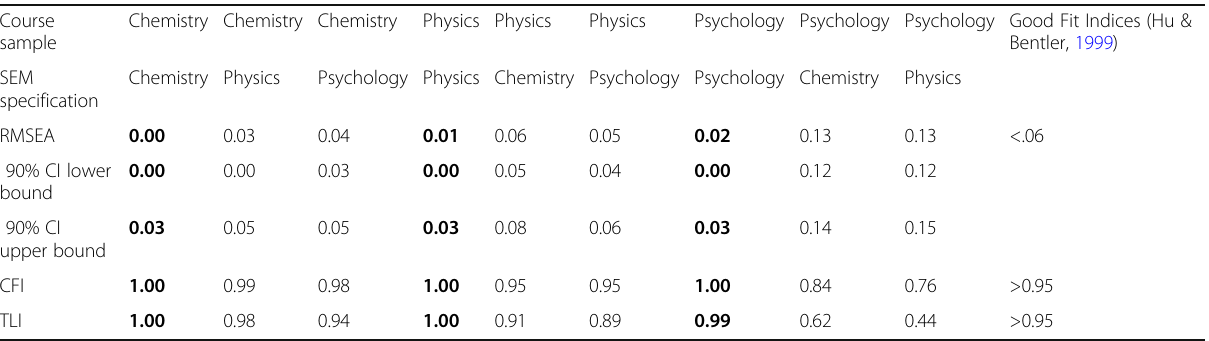
Table 8 Fit indices for all model